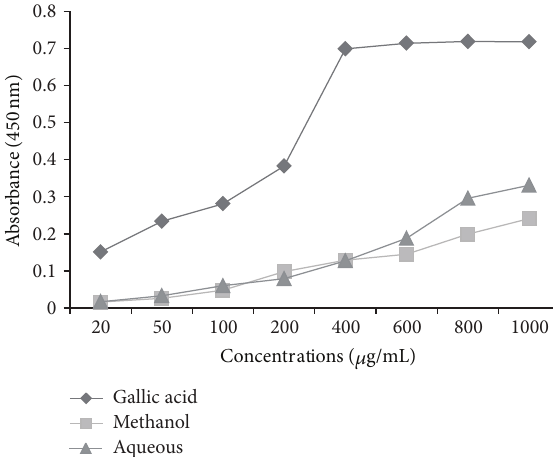
Figure 1: DPPH radical scavenging activity of methanol and aqueous extracts of P. aculeata L. leaves (values are average of triplicate experiment and are represented as mean ± SE).